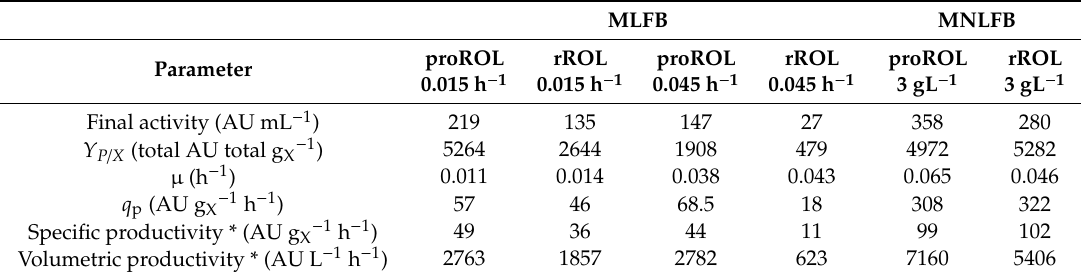
Table 2. Results of the fed-batch with rROL and proROL-strains under two methanol addition